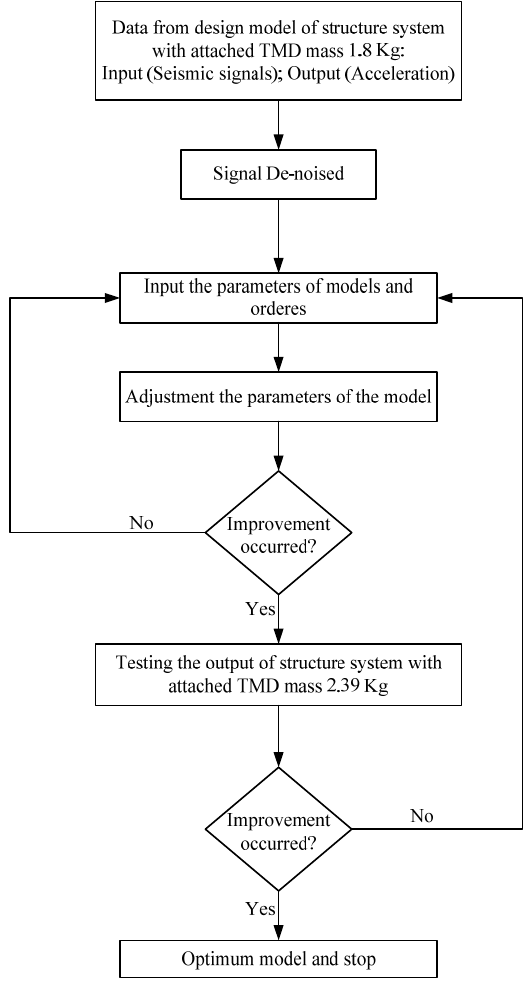
Figure 3. Proposed models procedure.